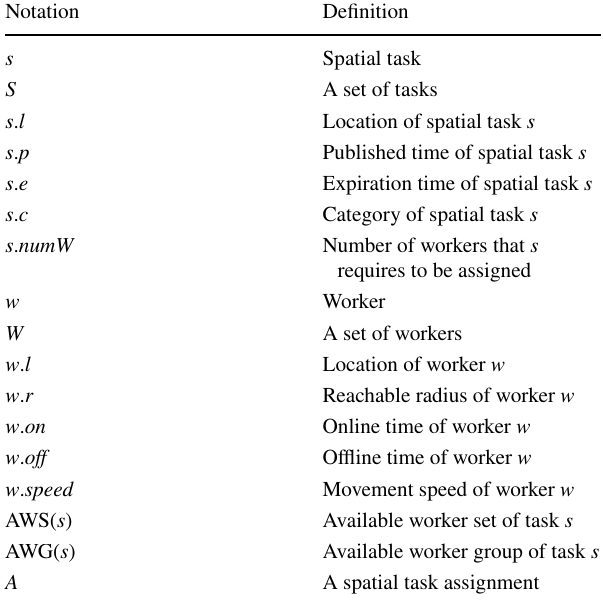
Table 1 Summary of